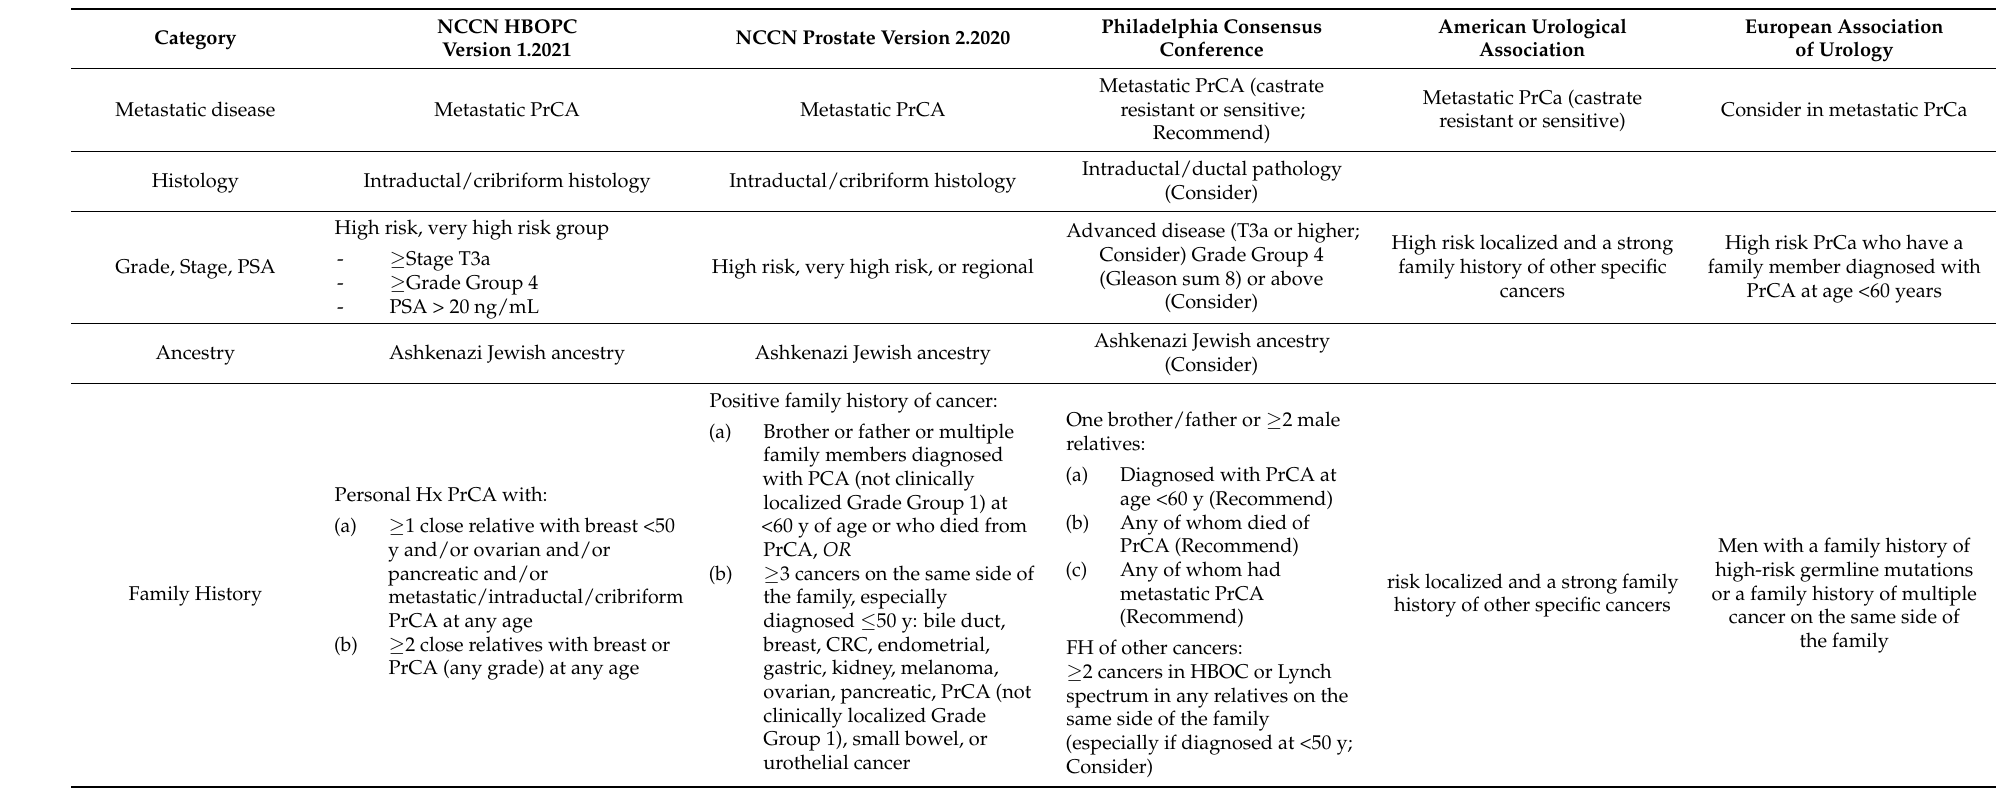
Table 1. Varying guidelines for genetic testing in prostate cancer (as presented from Clark et al. 2021